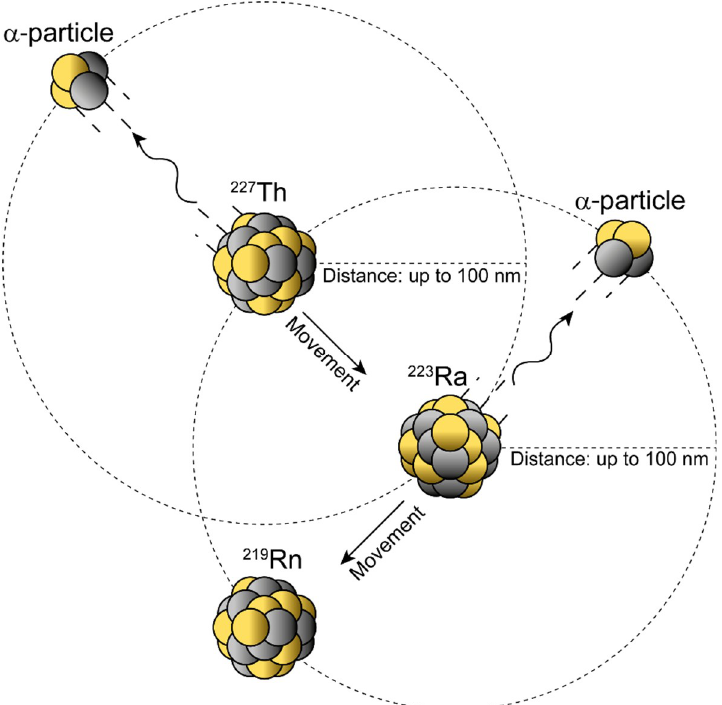
Figure 4. Nuclear recoil effect during α-decay within atomic in vivo nanogenerators. Schematic representation of the conservation of momentum law describing the transfer of the decay energy to the α-particle and daughter nucleus. The recoiling daughter nucleus can move up to ≈100 nm with each single α-decay and, hence, could travel considerable distances in a water-like environment (e.g., tissue). Note : The position of the α-particle is to show direction and not position.